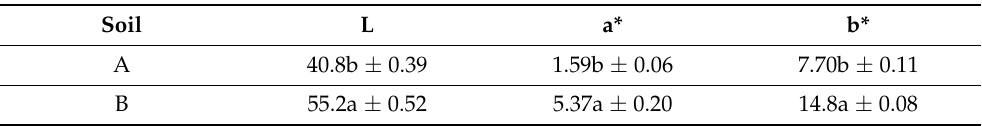
Table 2. Colorimeter parameters of the paddy rice field soil without humidity (A) and without hu- midity and organic matter (B) ± standard deviation ( n = 4). Letters a and b indicate significant dif- ferences among treatments ( p ≤ 0.05).